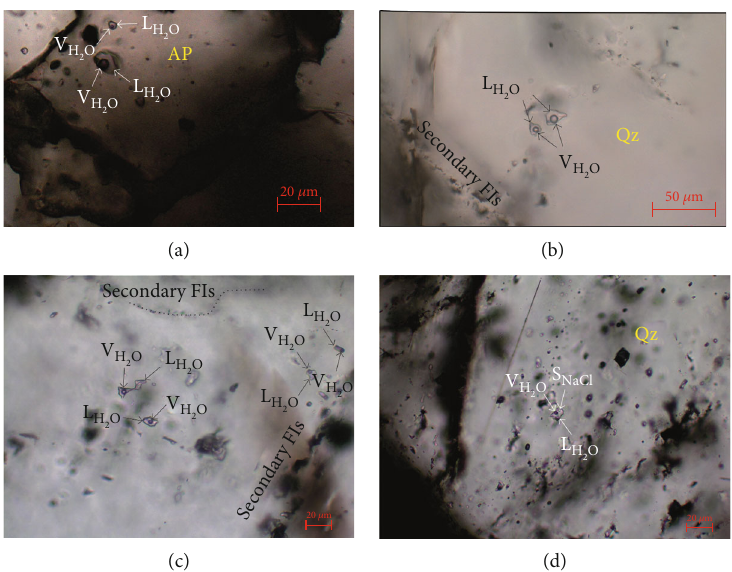
Figure 11: Photomicrographs showing the types and distribution of fl uid inclusions observed in the Xinmin deposit. (a) Primary aqueous inclusions in the main stage apatite. (b) Primary aqueous inclusions and secondary aqueous inclusions in the main stage quartz. (c) Primary aqueous inclusions and secondary aqueous inclusion in the late stage quartz. (d) Primary daughter mineral-bearing inclusions in the main stage quartz. Mineral abbreviations (after [19]): Ap: apatite; Qz: